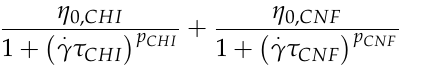
Figure 3. Flow diagrams showing the evolution of the viscosity ( η ) vs. shear rate ( 𝛾˙ ) of CNF-filled CHI suspensions and CHI reference solution, also displaying the modeling of the rheology data.